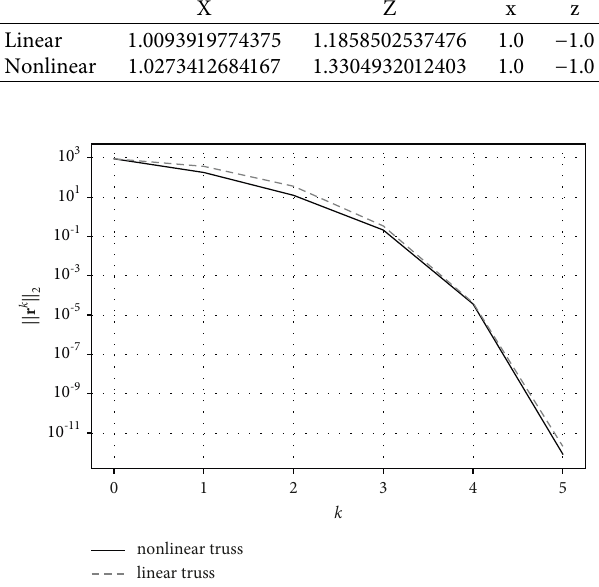
Figure 6: Convergence of the 3-bar system.